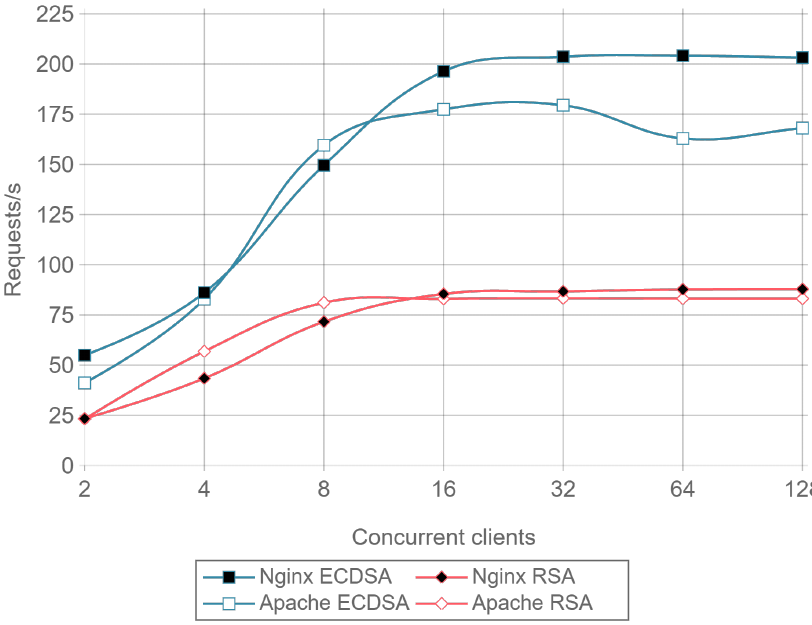
Figure 14. Server-side concurrent clients versus throughput for Apache2 and Nginx with 512 bytes of payload for Elliptic Curve Digital Signature Algorithm (ECDSA) and Rivest–Shamir–Adleman (RSA).